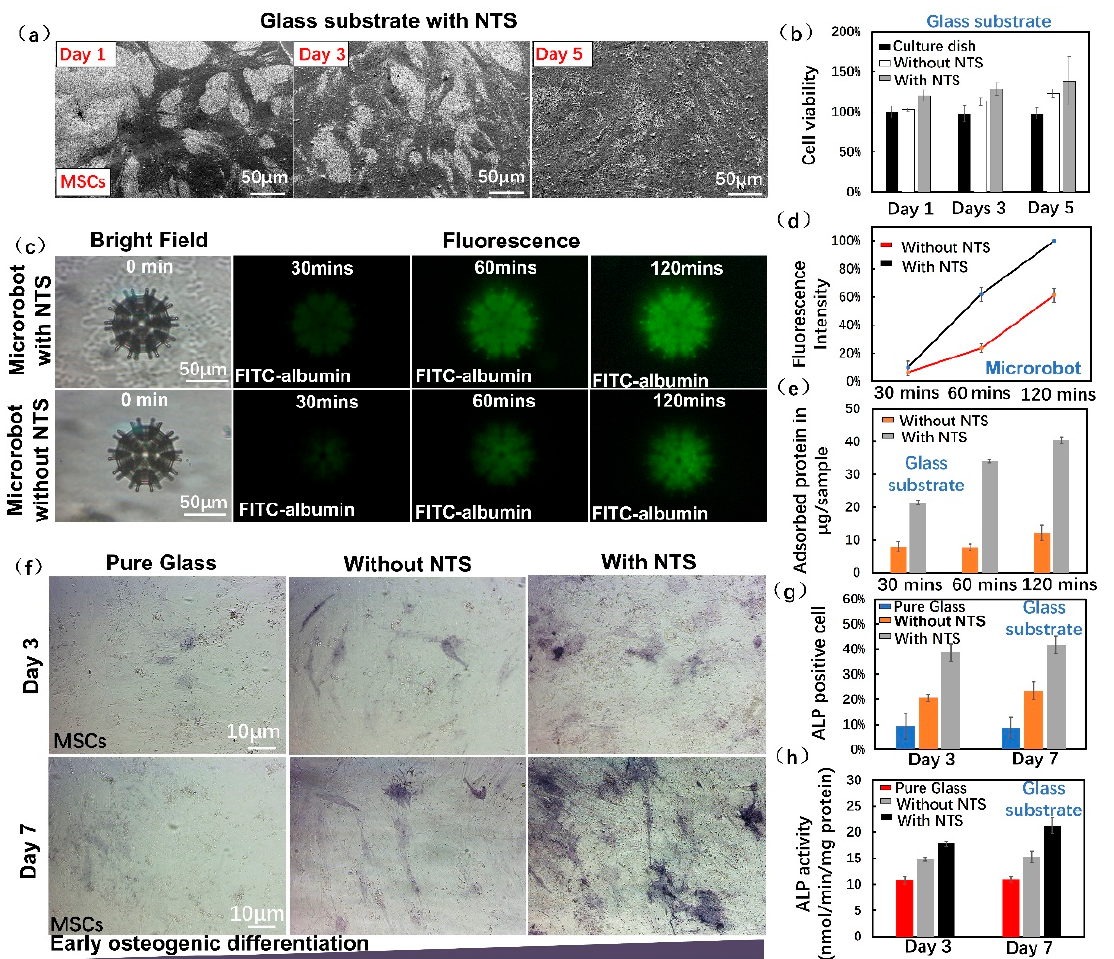
Figure 4. Cell biological evaluation on NTS: ( a ) SEM images of MSCs on glass substrate with NTS with days 1, 3 and 5 of culture; ( b ) Cell viability of MSCs on different substrates with days 1, 3 and 5 of culture (n = 3); ( c ) Bright field and fluorescence images of the FITC-albumin absorption on microrobot with and without NTS after 30, 60 and 120 min of incubation (n = 3); ( d ) Fluorescence intensity of microrobots with and without NTS vs. incubation time in FITC-albumin solution (n = 3); ( e ) Adsorption of protein onto glass substrate with and without NTS vs. incubation time in FITC-albumin solution (n = 3); ( f ) ALP staining images of MSCs grown on different substrates with days 3 and 7 of culture; ( g ) Percentages of ALP-positive cells on different substrates on days 3 and 7 of culture; ( h ) ALP activity of MSCs cultured on different substrates after osteogenic induction for 3 and 7 days (n = 3). Error bars indicate